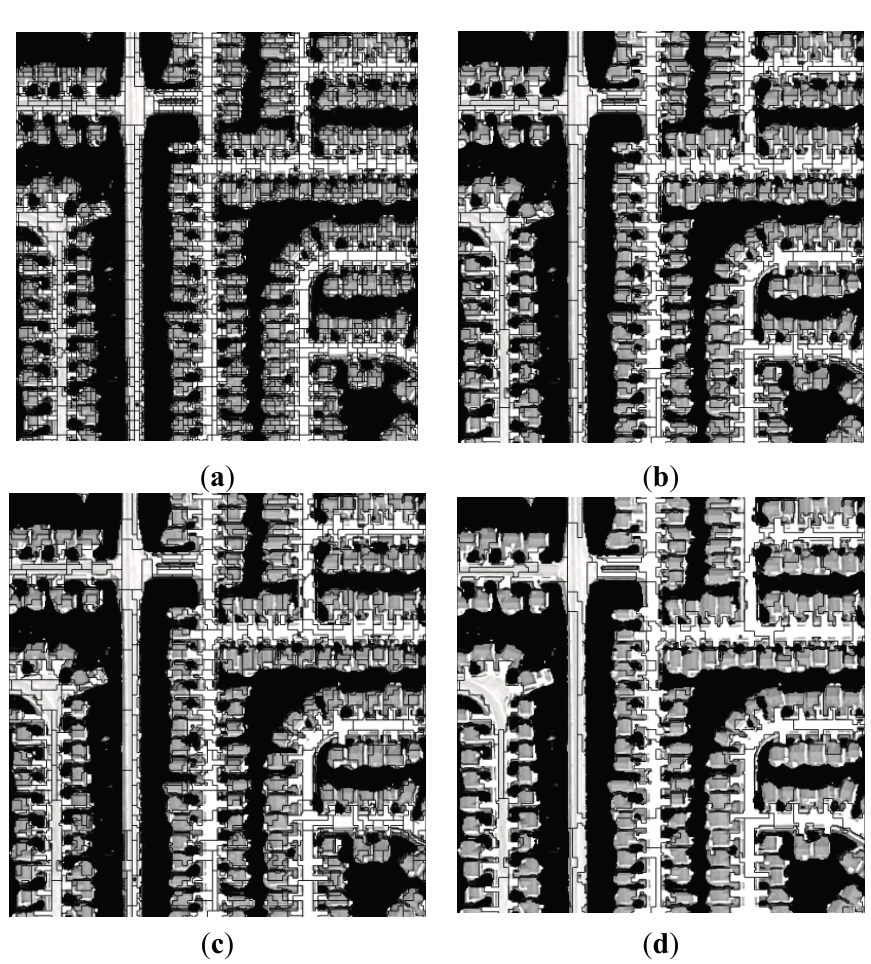
Figure 6. The building and road image objects were effectively refined and merged after using multi-resolution image region grow algorithm (MRSRG). ( a ) The building and road image objects after quadtree-based segmentation. ( b ) Image objects after the first time of MRSRG with parameters: scale = 10,000, shape = 0.1, compactness = 0.5. ( c ) Image objects after the second time of MRSRG with parameters: scale = 250, shape = 0.3, compactness = 0.5. ( d ) Image objects after the third time of MRSRG with parameters: scale = 50, shape = 0.3, compactness =